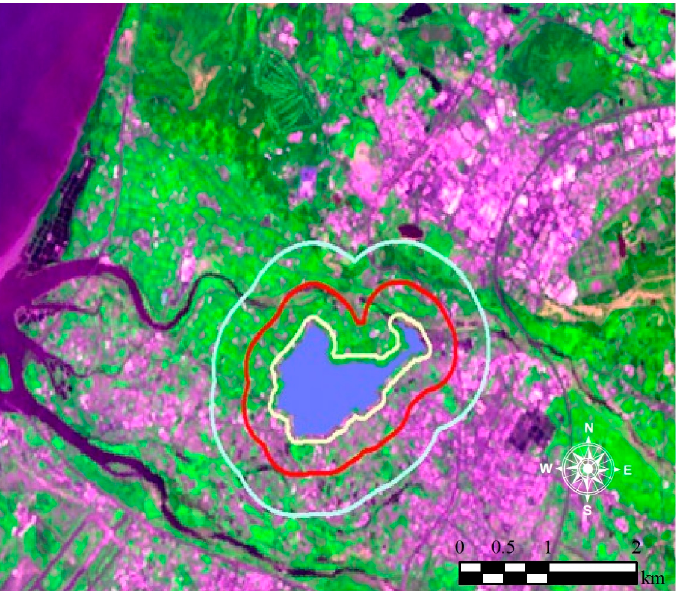
Figure 7. Buffer analysis graph (the blue area is the group’s region; the yellow, red, and light green lines are 100 m, 500 m, and 1000 m boundaries, respectively) of the Gobei work group, Hsinchu Irrigation